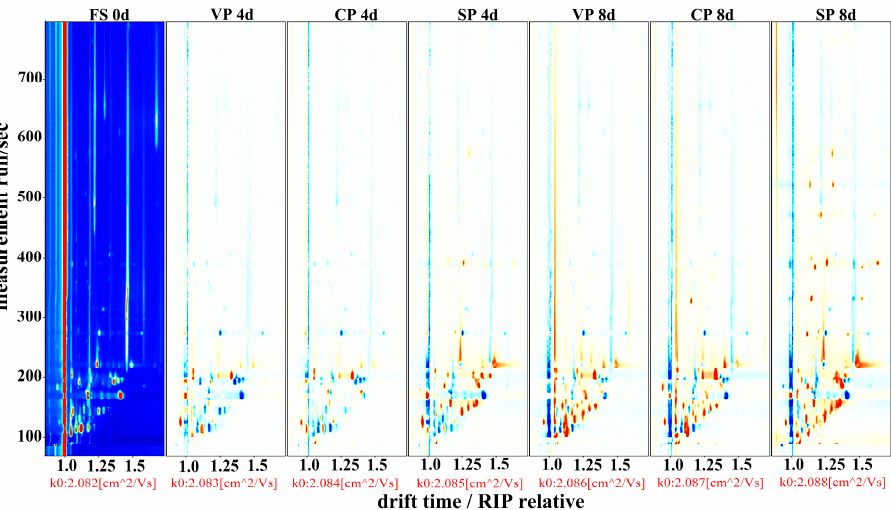
Figure 6. Topographical plots of volatile compounds corresponding to GC–IMS signals detected in different pike-eel samples during chilled storage. FS, fresh sample; SP, simple packaging; VP, vacuum packing; and CP, stable chlorine dioxide treatment combined with vacuum packing. Red and blue dots represent higher and lower concentrations of volatile compounds in the target samples, compared with that in the fresh samples (0 days), respectively.